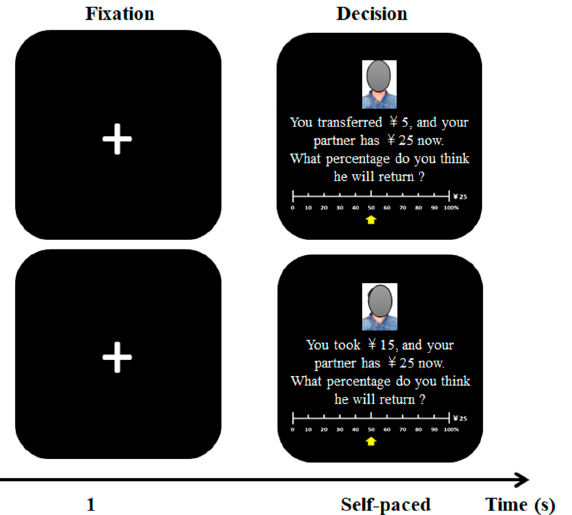
Figure 5. The display of the expectation task in the trust game (TG) (upper part) and distrust game (DTG) (lower part). After a Fixation was shown (1 s), the Decision screen showed the face of the partner, the amount given or taken away, and the amount that the partner held after stage 1. Participants made their estimations by moving the arrow with the left or right arrow key. They locked their choices by pressing the enter key. Participants made their choices at their own pace. Note that the texts in the original picture are in Chinese. They are translated into English for communication purposes.